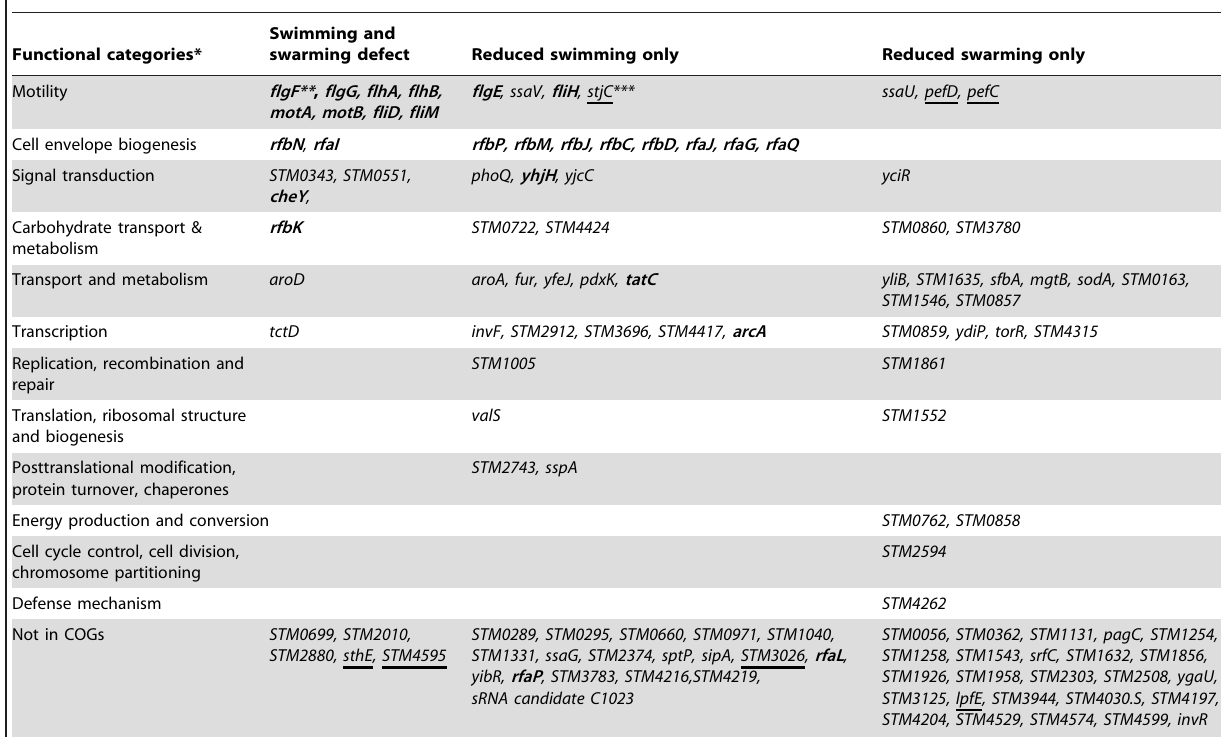
Table 1. Pathway clustering of mutants with altered